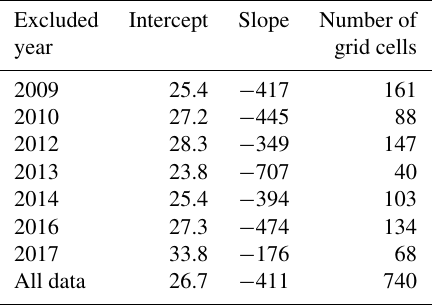
Table 2. The regression coefficients of snow depth estimation equa- tions based on OIB snow depth data in different years.